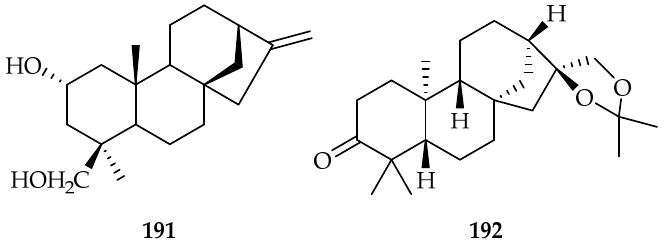
Figure 78. Structures of aleuritopsis B 191 [109] and compound 192 [124].